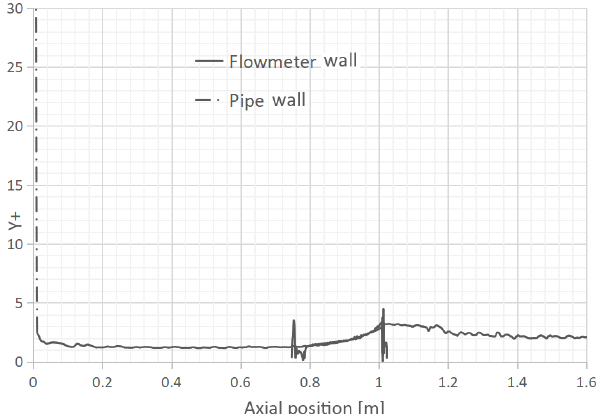
Figure 8. y + trend in the flowmeter and pipe walls’ proximity, SG cone.